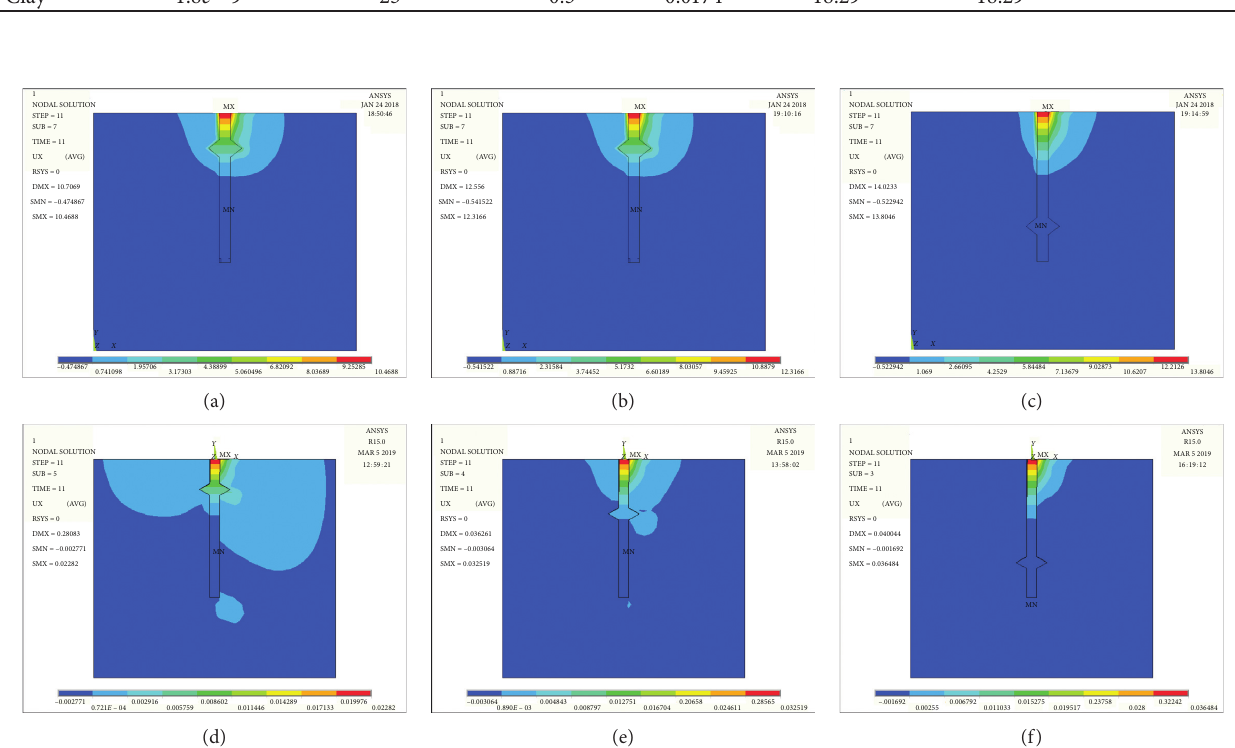
Figure 17: Displacement nephogram of rigid and flexible piles. (a) GM1 displacement nephogram. (b) GM2 displacement nephogram. (c) GM3 displacement nephogram. (d) RM1 displacement nephogram. (e) RM2 displacement nephogram. (f) RM3 displacement nephogram.